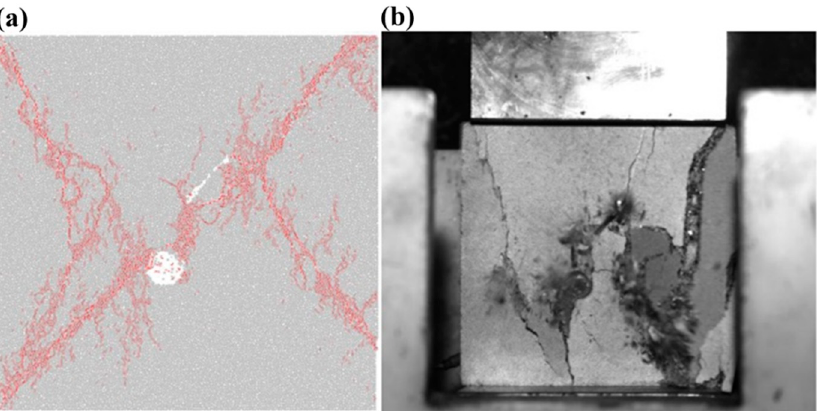
Figure 2. Comparison of ( a ) the numerical and ( b ) experimental failure modes of rock specimens containing holes and fissures under uniaxial compression.